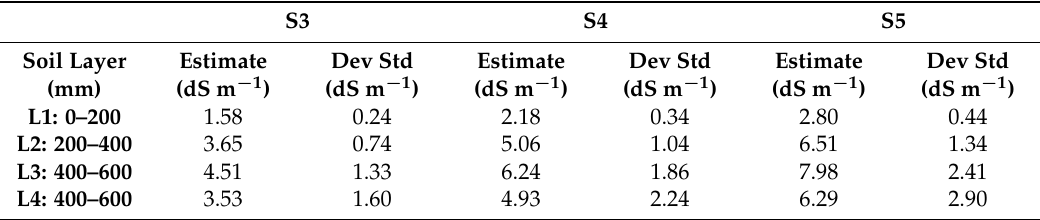
Table 2. Estimates of the average annual values of soil salinity under the effect of the three